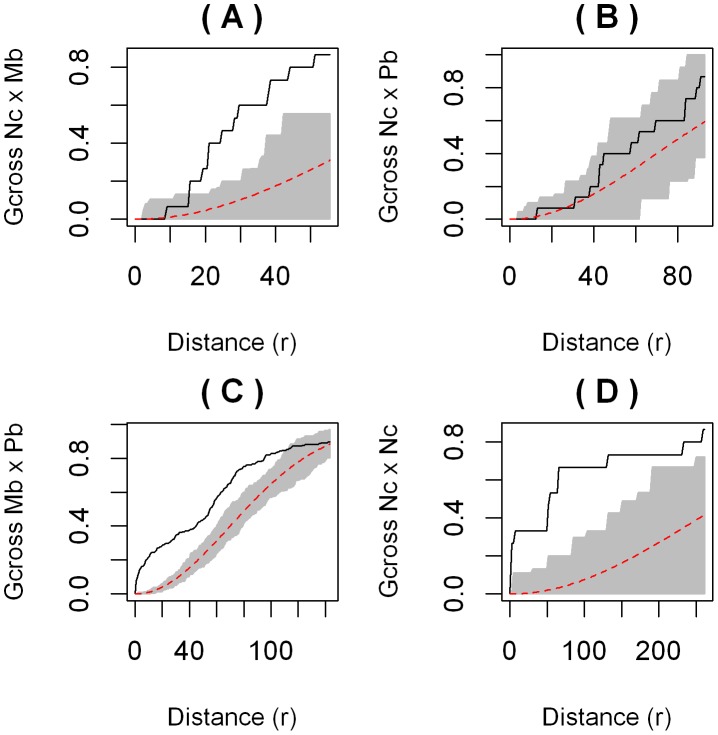
Gcross analysis of Hansen's disease.A. New (Nc) versus previous multibacillary cases (Mb). B. New (Nc) versus previous paucibacillary cases (Pb). C. Previous Multibacillary (Mb) versus Paucibacillary cases (Pb). D. New Hansen's disease cases (Nc).